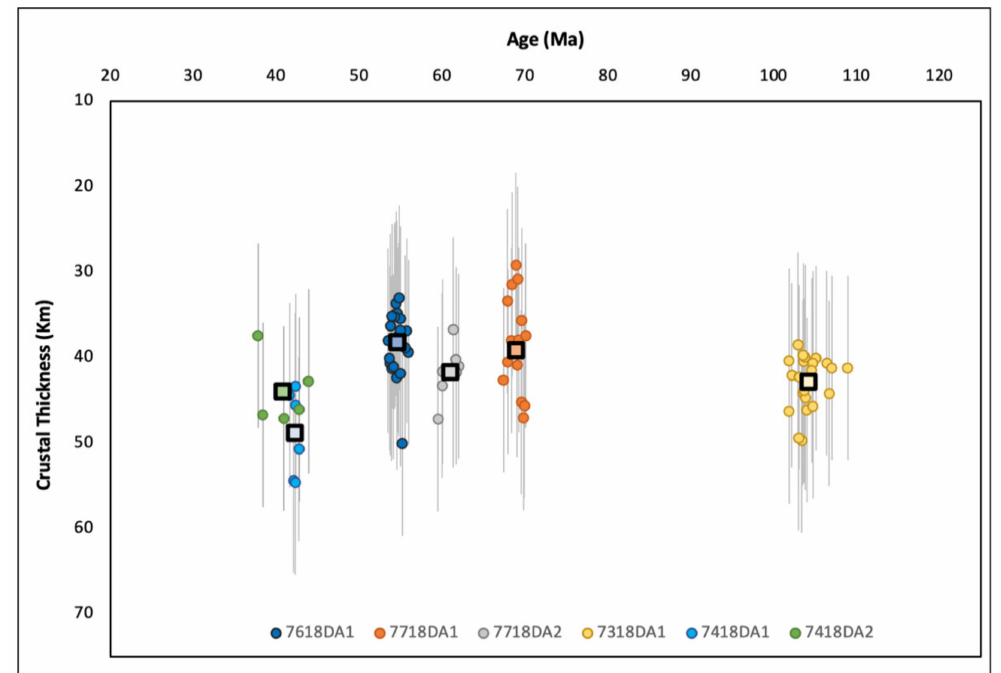
Figure 6. Trace/rare earth element (T/REE) geochemistry crustal thickness estimates for igneous zircons plotted against corresponding U-Pb geochronology crystallization ages. Crustal thickness estimates were calculated using the equations of Sundell et al. (2021) [89] modified from the original equations calibrated by Profeta et al. (2015) [21]. These equations utilize La/Yb ratios as proxies for depth of magma diversification and, thus, crustal thickness at the time of crystallization (see Supplementary Figure S2). Error bars represent ± 10.8 km (2 σ ) residuals [89]. Larger circles with black outlines represent mean crustal thickness estimates for each sample. Moving right to left through time across the chart, average crustal thickness estimates decrease thickness from ~100 Ma to ~70 Ma, followed by increasing thickness estimates until ~40 Ma. Complete zircon T/REE geochemistry results for individual grains can be found in Supplementary Table